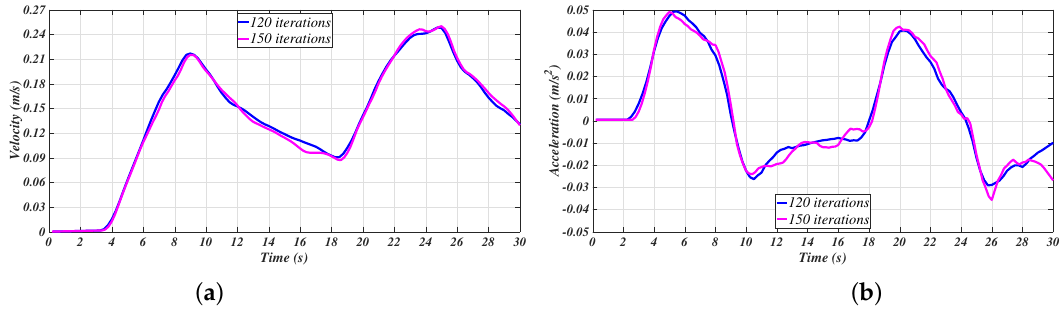
Figure 8. Case 3 comparison of filtered signals: ( a ) Velocity. ( b ) Acceleration. A second filter was applied to the already filtered accelerations obtained at cases 2–5, as suggested by [11–13]. For such a task, the second filter parameters, as shown in Table 2, were established, and new labels for these cases were assigned. Table 2. Parameters of the second Savitzky–Golay acceleration filter.